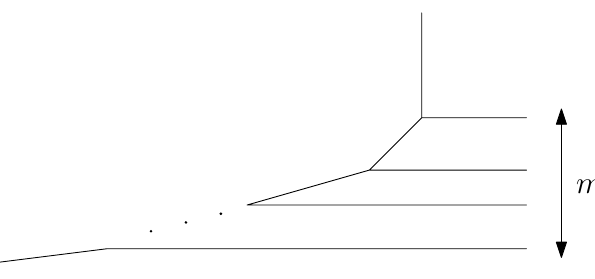
Figure 3. Toric diagram of ] eral CY 3 m;n